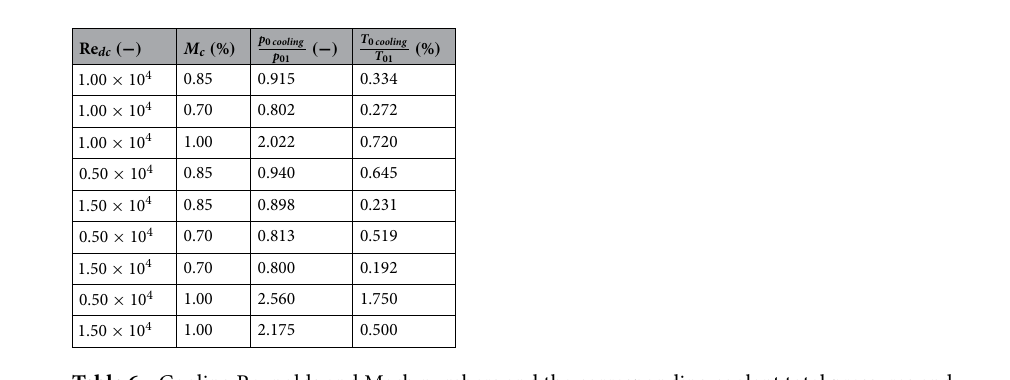
Table 6. Cooling Reynolds and Mach numbers and the corresponding coolant total pressures and temperatures.